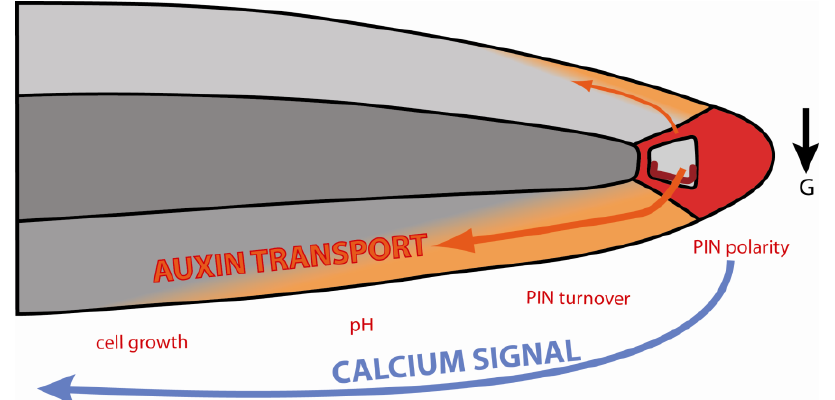
Figure 5. Interplay between auxin transport and calcium signaling during root gravitropism. Graviperception causes PIN repolarization in the columella, redirecting auxin flow to the lower side of the root. The new auxin flux is associated with local Ca 2+ signals, altered PIN polarity and turnover, pH changes and inhibition of elongation. (The black arrow indicates the direction of